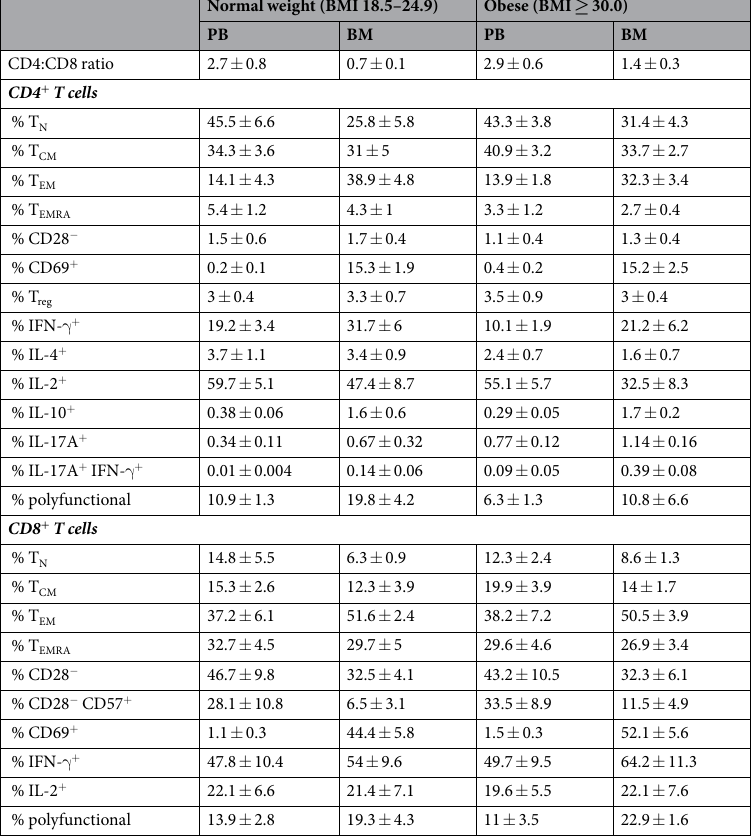
Table 1. The impact of obesity on T cell subsets in the peripheral blood and bone marrow of OA patients. Data are expressed as mean ± SEM. T reg cells were defined as CD25 hi CD127 dim cells. Polyfunctionality was defined as cells that simultaneously produced IFN- γ , TNF- α and IL-2. PB = peripheral blood; BM = bone